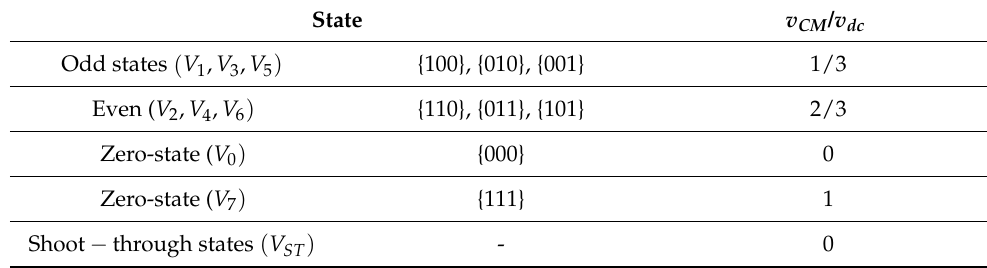
Table 2. Common-mode Voltages for QZSI.